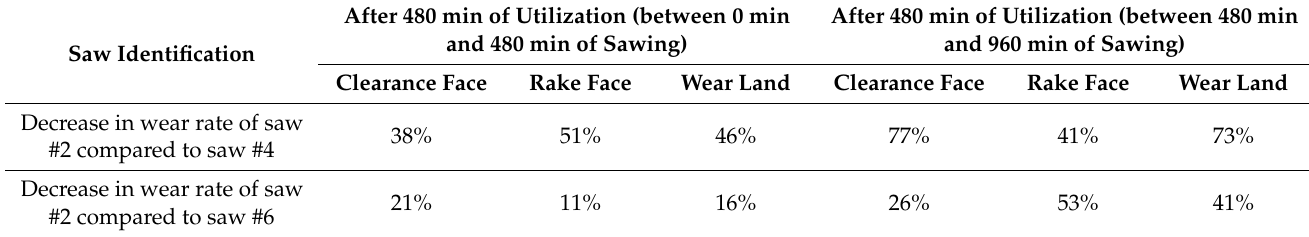
Table 9. Decrease in wear rate (percentage) when using coated and edge-modified